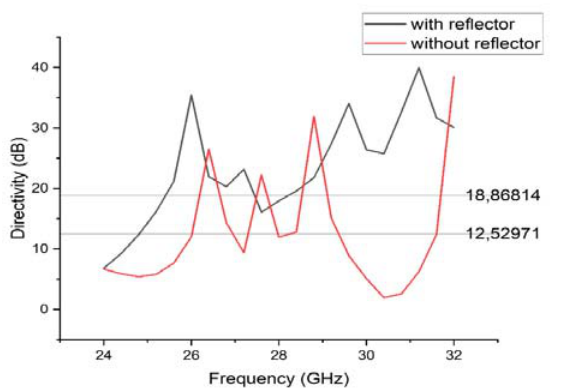
Fig 12. Comparison of directivity antenna with and without reflector